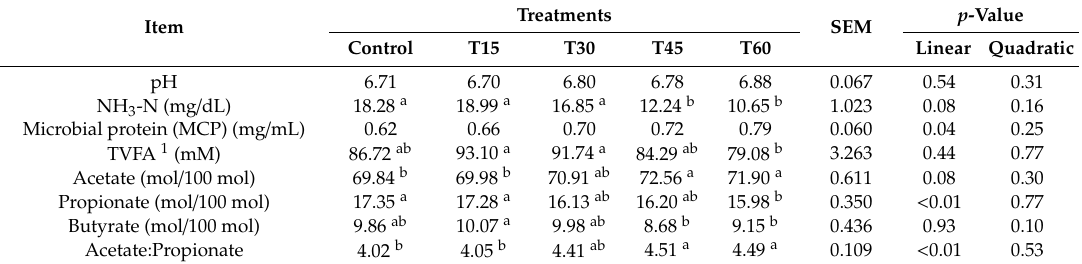
Table 4. Rumen fermentation parameters in rumen fluid of fattening Hu sheep fed with mulberry leaf powder.